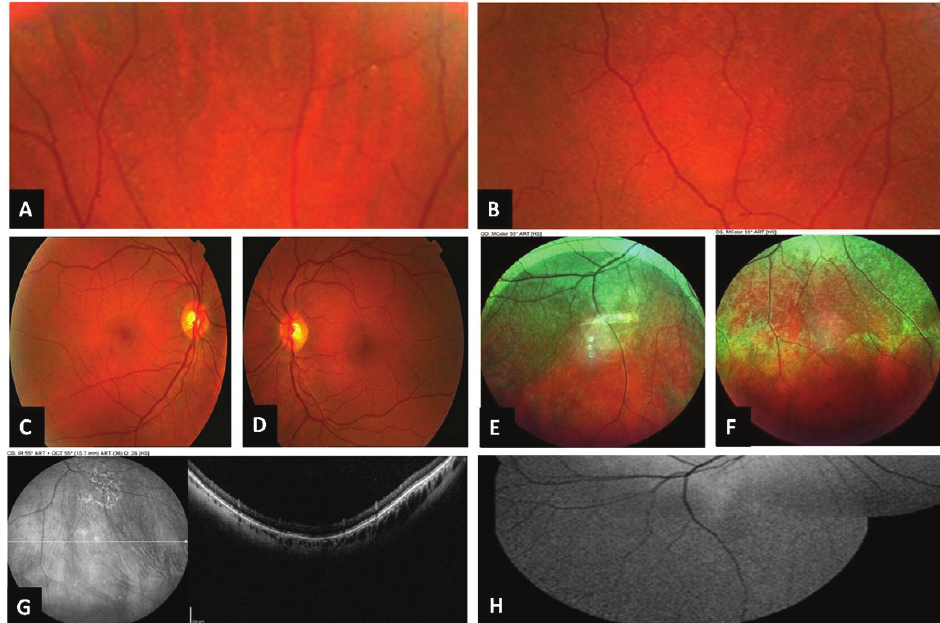
Figure 2. Magnified peripheral fundus photographs of the right (A) and left (B) eyes revealed many small yellowish punctate lesions; optic nerve, macular area, and vessels are normal in the right (C) and left (D) eyes; peripheral fundus multicolor images of the right (E) and left (F) eyes showed much more visible and detectable lesions in comparison to the fundus photographs; peripheral optical coherence tomography detected SDD-like lesions in the left eye (G), right eye revealed similar findings (not shown); magnified fundus autofluorescence showed a mottled hyper- and hypoautofluorescent pattern in the periphery of the retina in the right eye (H), similar to the left eye (not